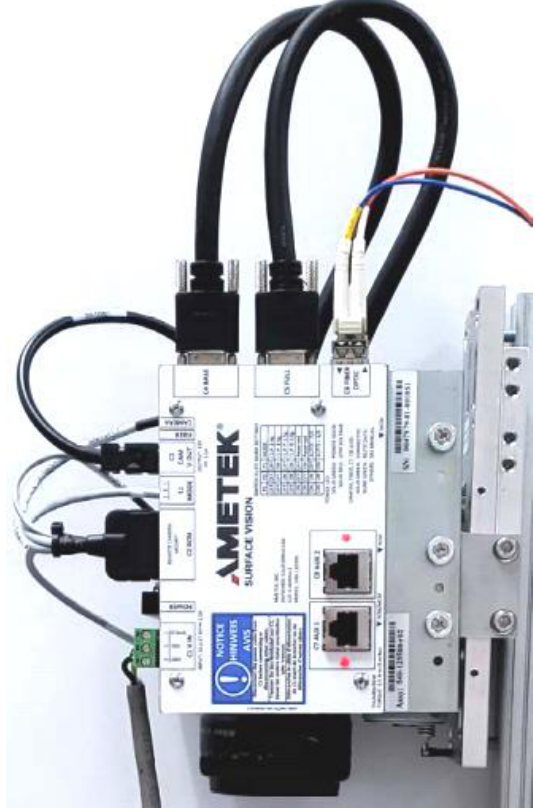
Figure 4. Surface inspection camera with Ametek Camera Link Interface module [31].